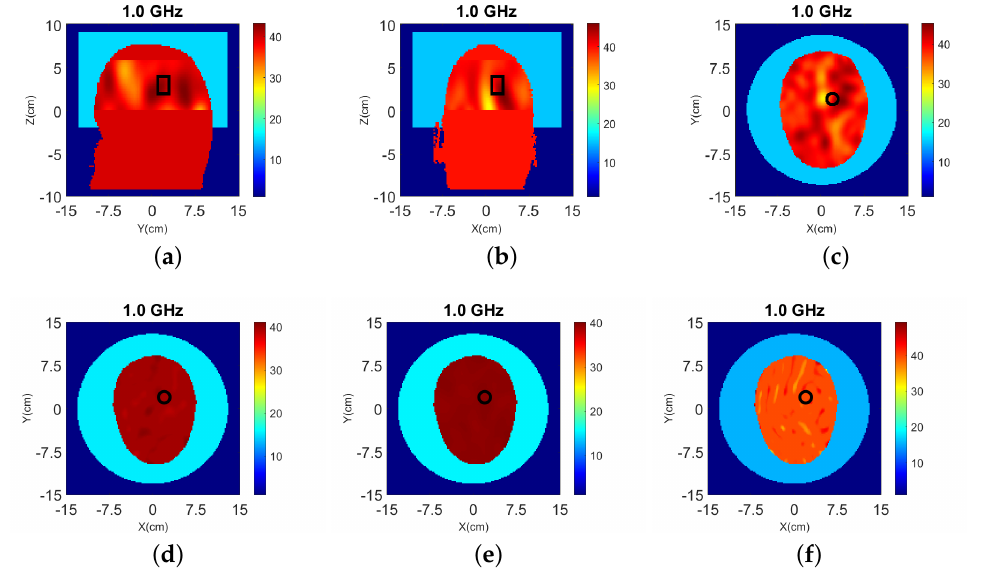
Figure 16. 3-D ( a – c ) and 2-D ( d – f ) reconstructions of Case III.1 at 1.0 GHz: ( a ) y-z slice, ( b ) x-z slice, and ( c ) x-y slice of 3-D reconstructions. 2-D slice reconstructions ( d ) bottom ring, ( e ) top ring, and ( f ) both rings. The headband of Figure 14 is used to obtain the